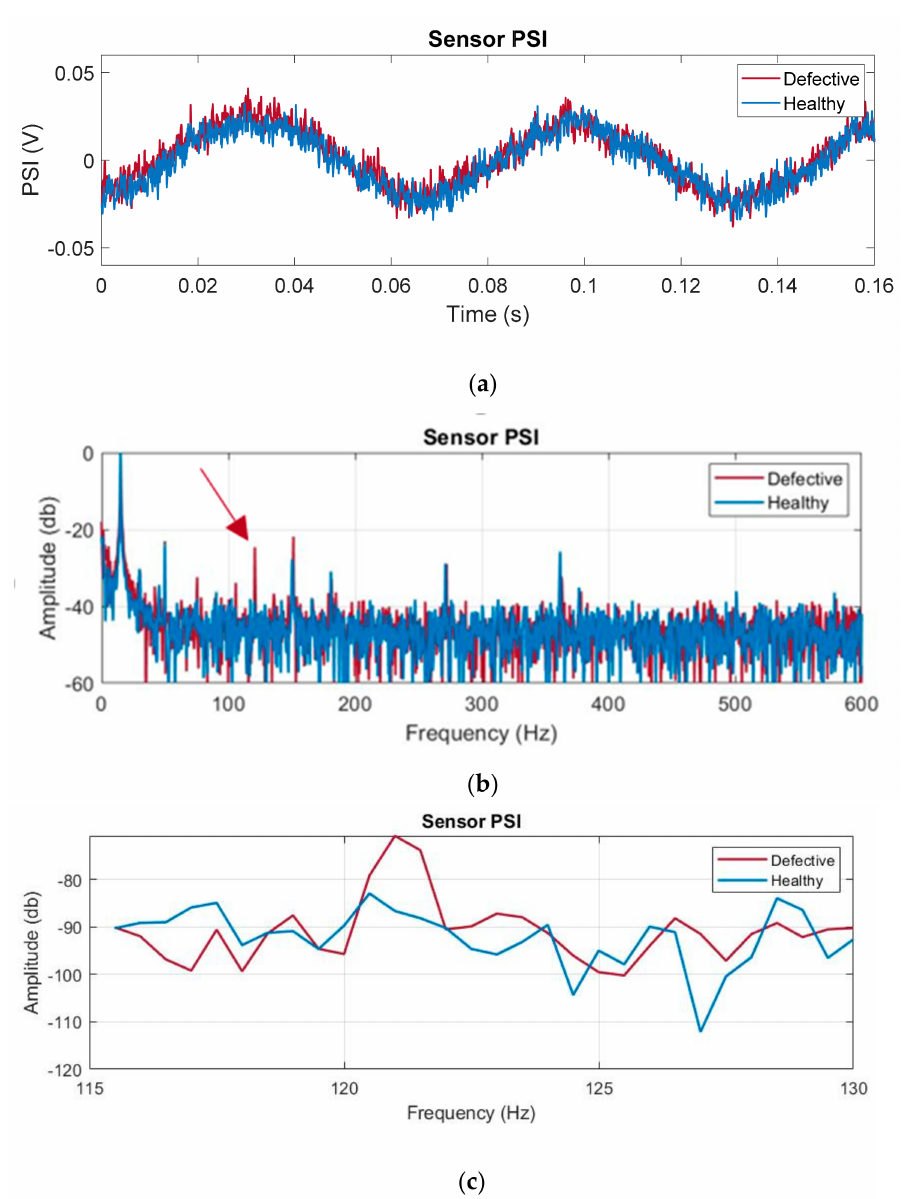
Figure 19. Investigation of position sensor misalignment defect at 910 rpm, 65% of rated torque, and single defective position sensor. ( a ) Waveform of piezoelectric sensor PSI output, ( b ) Frequency spectrum of piezoelectric sensor PSI output, ( c ) Narrow frequency spectrum of piezoelectric sensor PSI with Goertzel